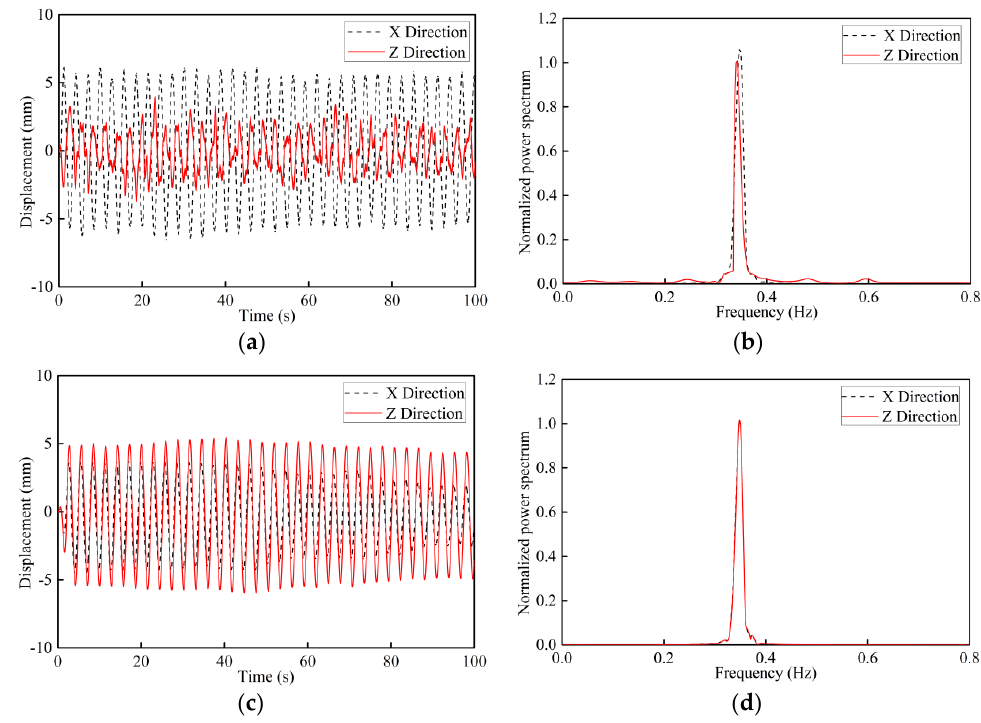
Figure 10. Observed data of the OWT in parking conditions: ( a ) Displacement time histories of 2.0